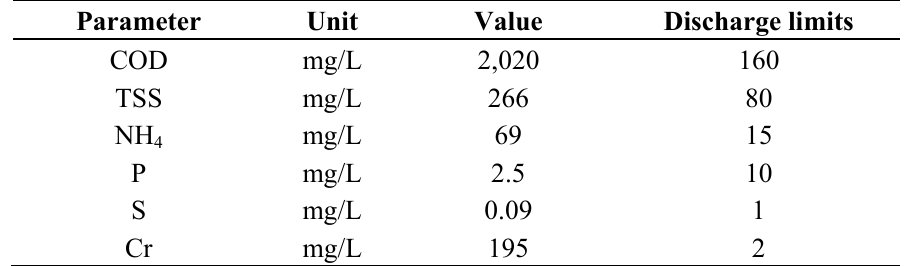
Table 2. Characteristics of the tannery wastewater stream after primary treatment